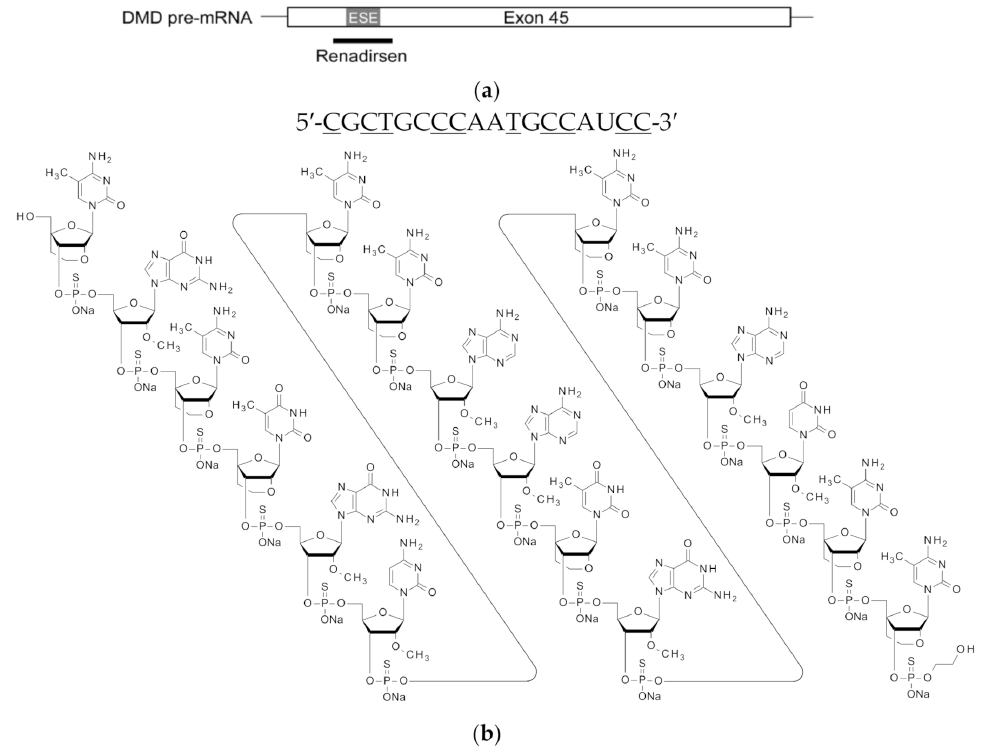
Figure 1. Schematic of the location, nucleotide sequence, and structure of renadirsen. ( a ) The location of renadirsen is schematically presented. Box and bars indicate exon 45 and flanking introns, respectively. The thick bar represents renadirsen. ( b ) Nucleotide sequence (upper) and structure (bottom) of renadirsen. Capital letters and underlined capital letters indicate 2 (cid:48) OMeRNA and ENA, respectively. ENA-C and ENA-T represent 2 (cid:48) - O ,4 (cid:48) - C -ethylene-5-methylcytidine and 2 (cid:48) - O ,4 (cid:48) - C -ethylene-5-methyluridine, respectively. A 2-hydroxyethyl phosphate group was attached at the 3 (cid:48) -end of renadirsen. All internucleotide bonds of renadirsen are phosphorothioate